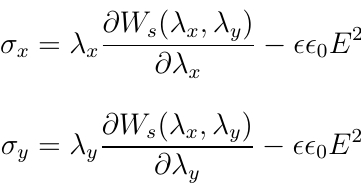
a and ˆ e denote the direction of the a b